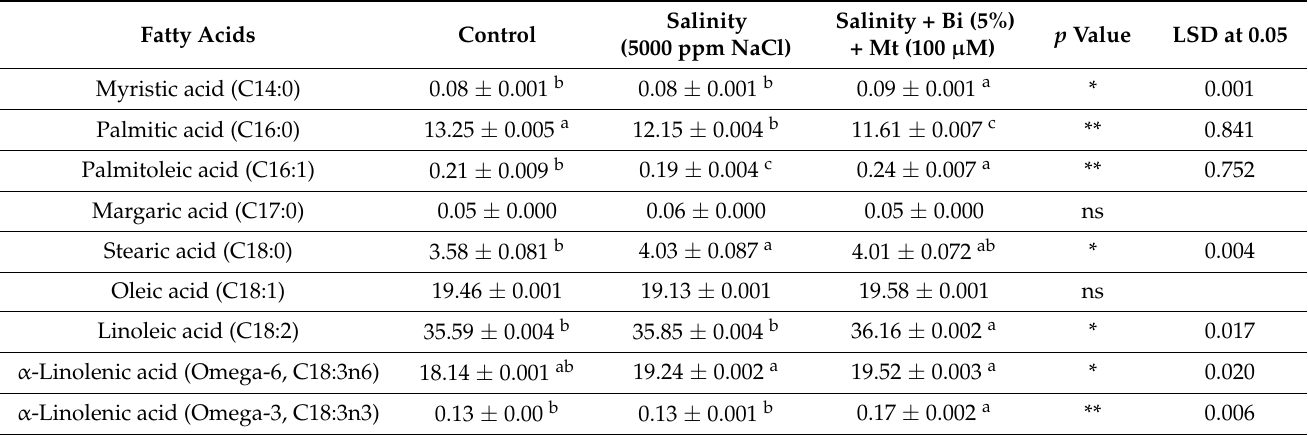
Table 7. GLC fractions of borage oil of selected